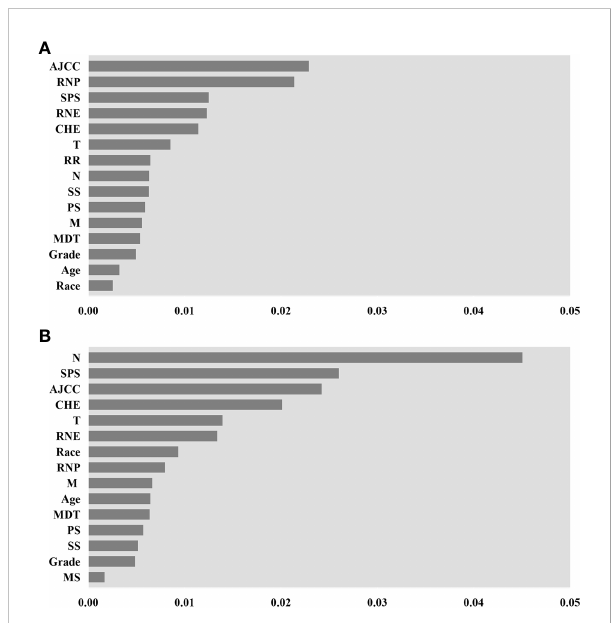
FIGURE 6 Feature importance for DeepSurv and random survival forest (RSF) models, only the top 15 variables in importance are shown in the fi gure. (A) is the importance of features measured by the RSF model. (B) is by DeepSurv. AJCC stage (AJCC), Regional nodes positive (RNP), Surgery of the primary site (SPS), Regional nodes examined (RNE), Chemotherapy (CHE), T stage(T), radiation recodes (R.R.), N stage (N), Summary Stage (S.S.), Primary Site (P.S.), M stage (M), Months from diagnosis to treatment (MDT), Marital status